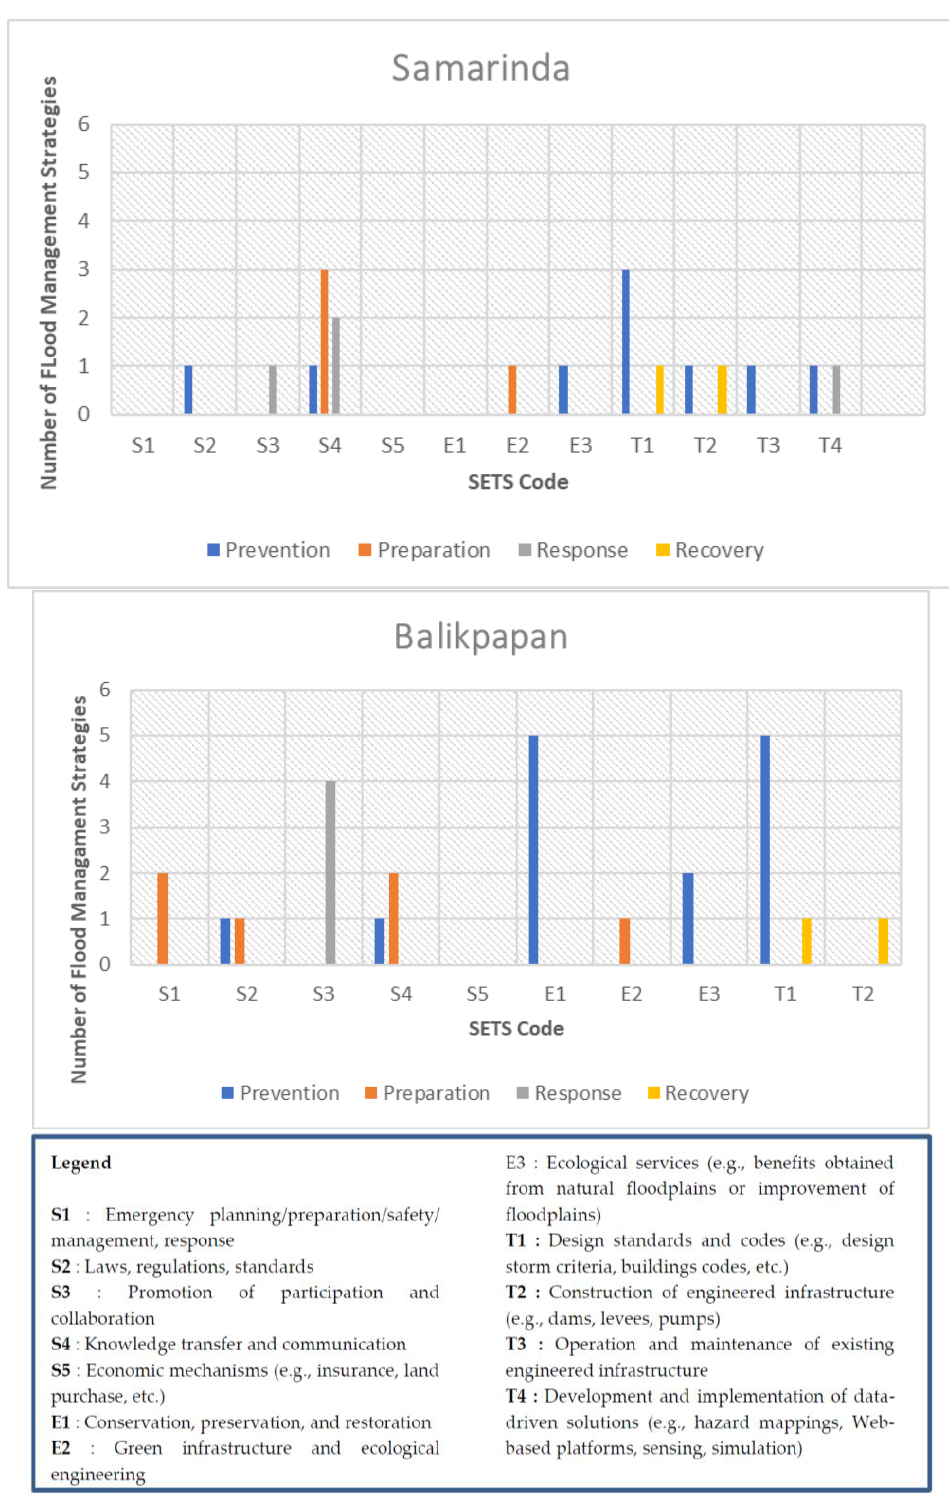
Figure 8. Comparison of SETS code in each Flood Resilience Phase (Source: authors) .